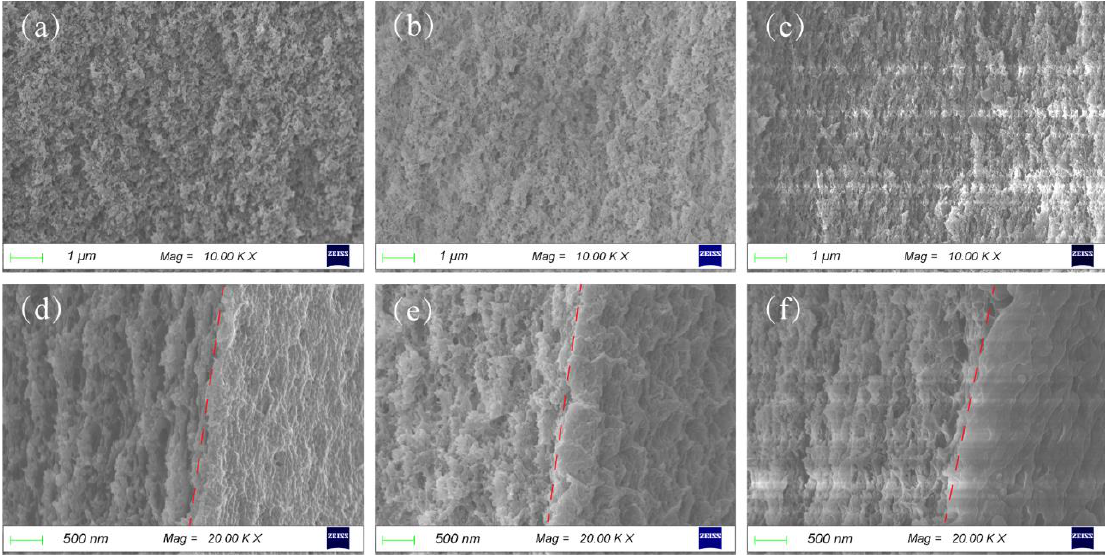
Figure 3. SEM micrographs of CPMs: ( a – c ) cross-section micrographs of CPM0, CPM5, and CPM10, respectively; ( d – f ) micrographs of the junction between the cross-section (left side of the red dashed line) and the surface (right side of the red dashed line) of CPM0, CPM5, and CPM10, respectively. Based on the SEM micrograph analysis, five CPMs, CPM-0, CPM-3, CPM-5,